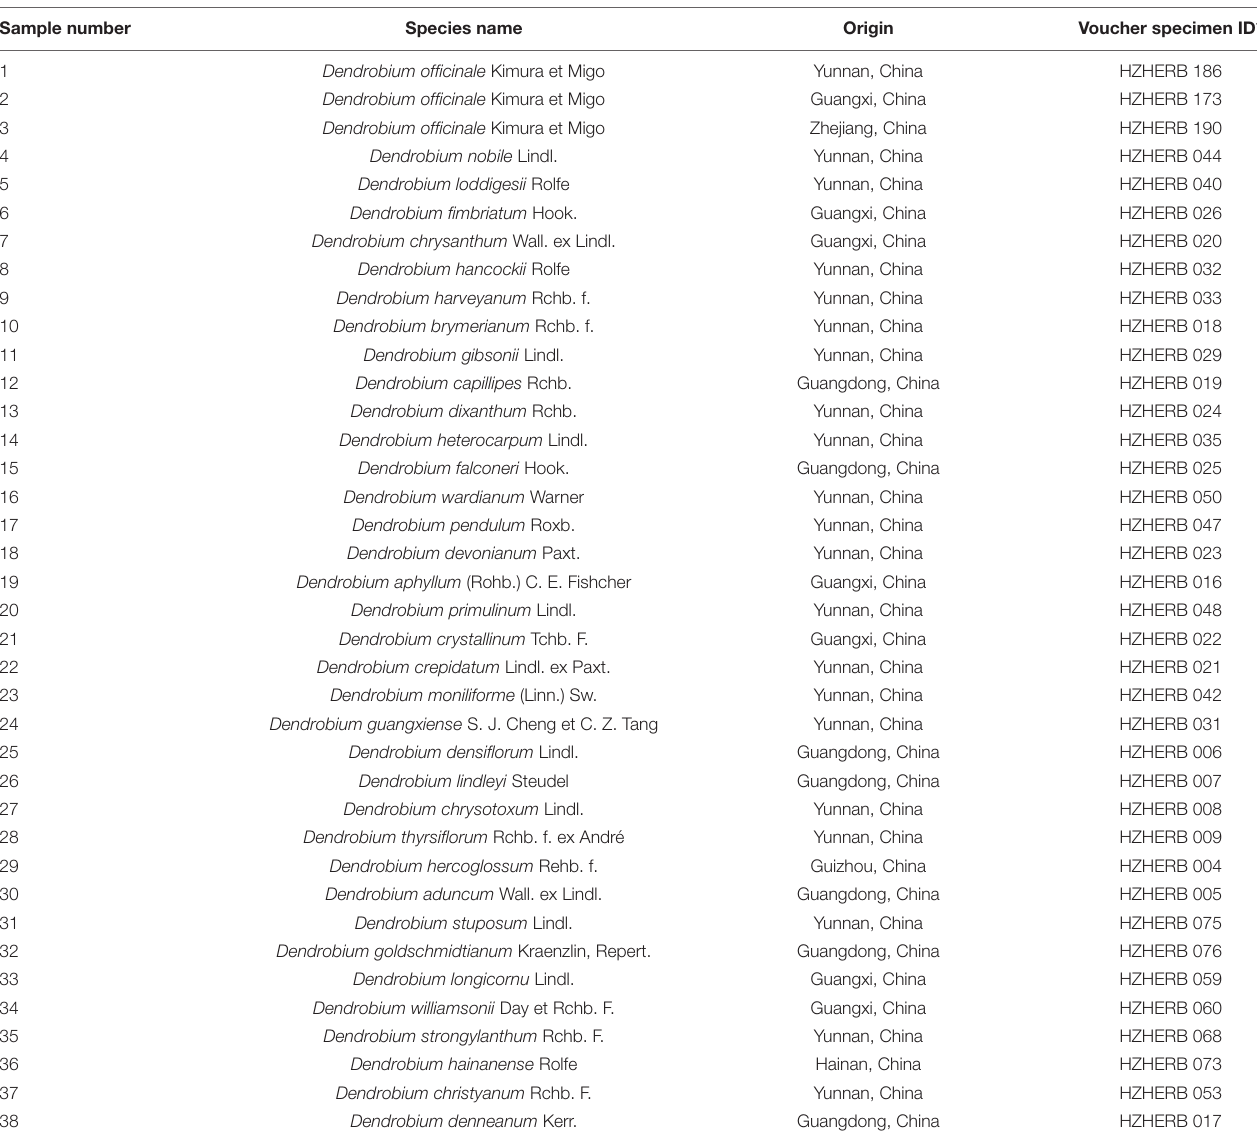
TABLE 1 | The information for all Dendrobium samples used in the SCoT